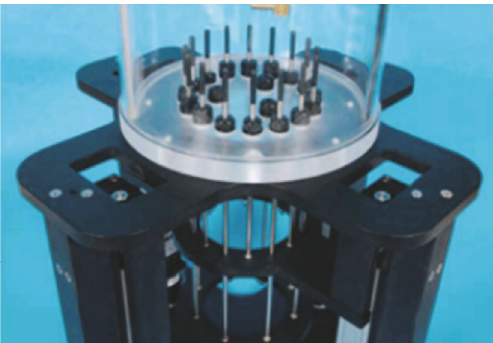
Figure 10: The 3D microwave tomographic breast cancer imaging system of Dartmouth College [19]. Image copyright IEEE, used with permission.